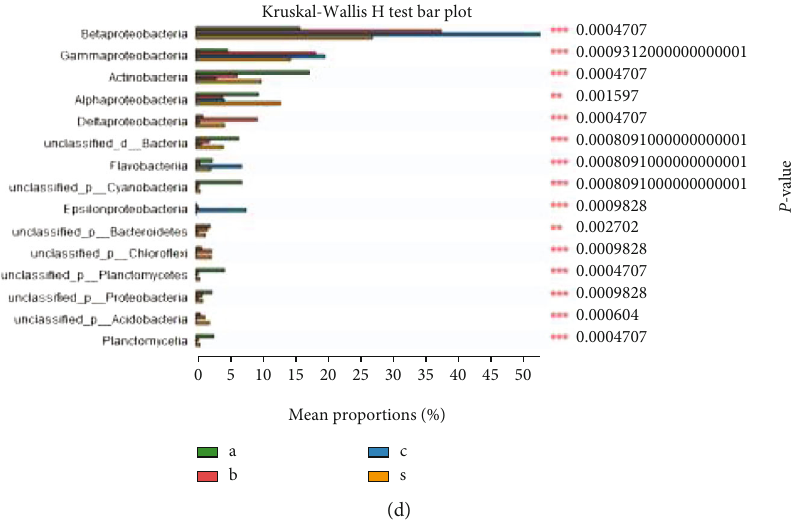
Figure 2: Variations in the bacterial population composition at the (a) phylum, (b) genus, (c) species, and (d) class